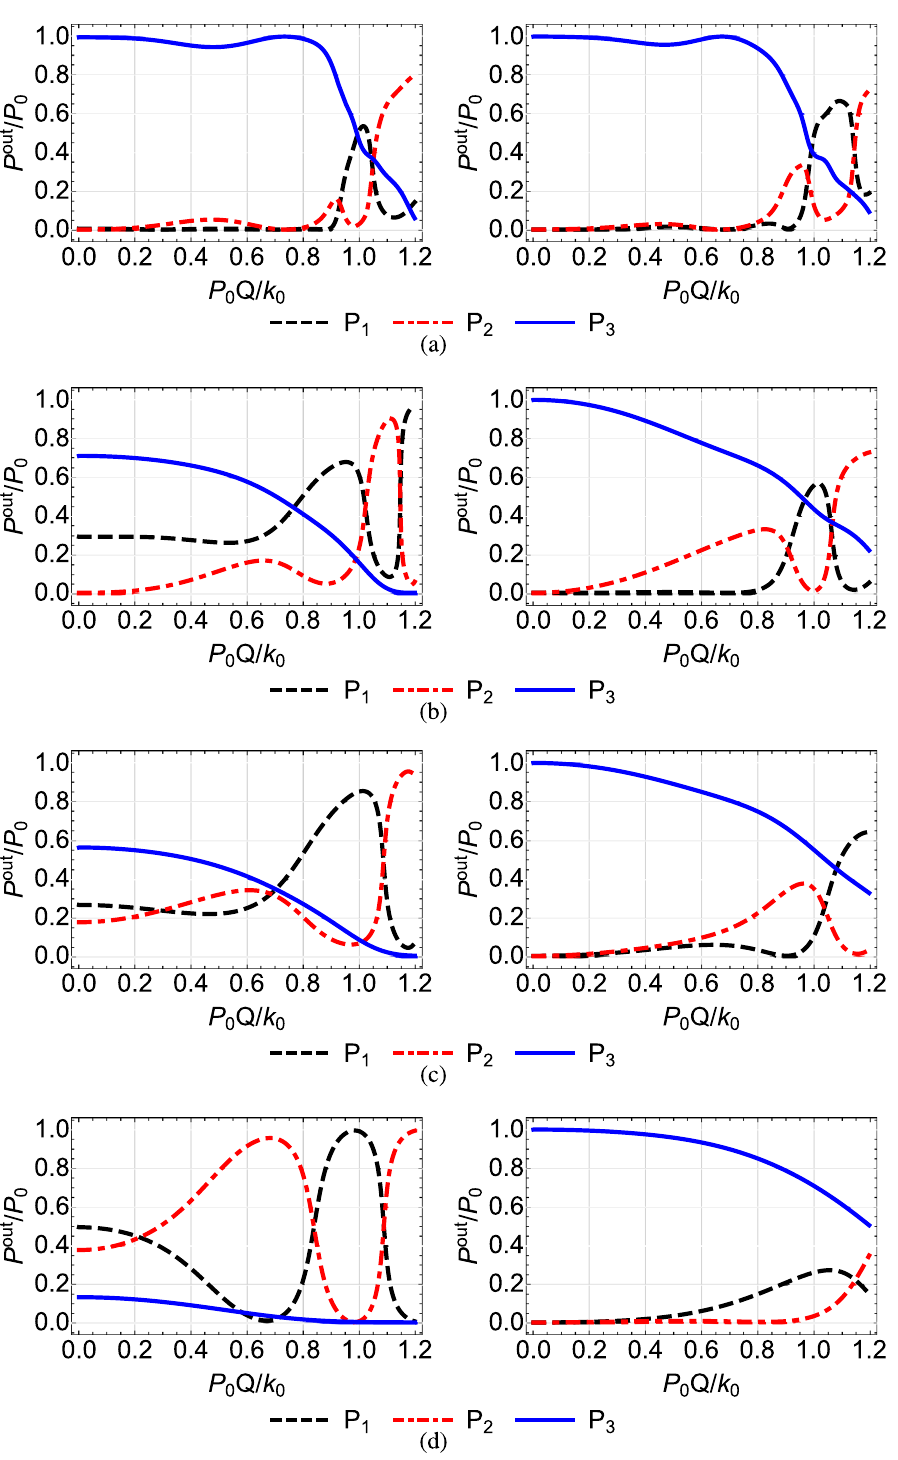
out P P i ( Z )/ P 0 0 at each waveguide as a function of the normalized i / = Q , Q Q , Q Q , for the Gaussian (left column) and modified shortcut 2 3 = = =